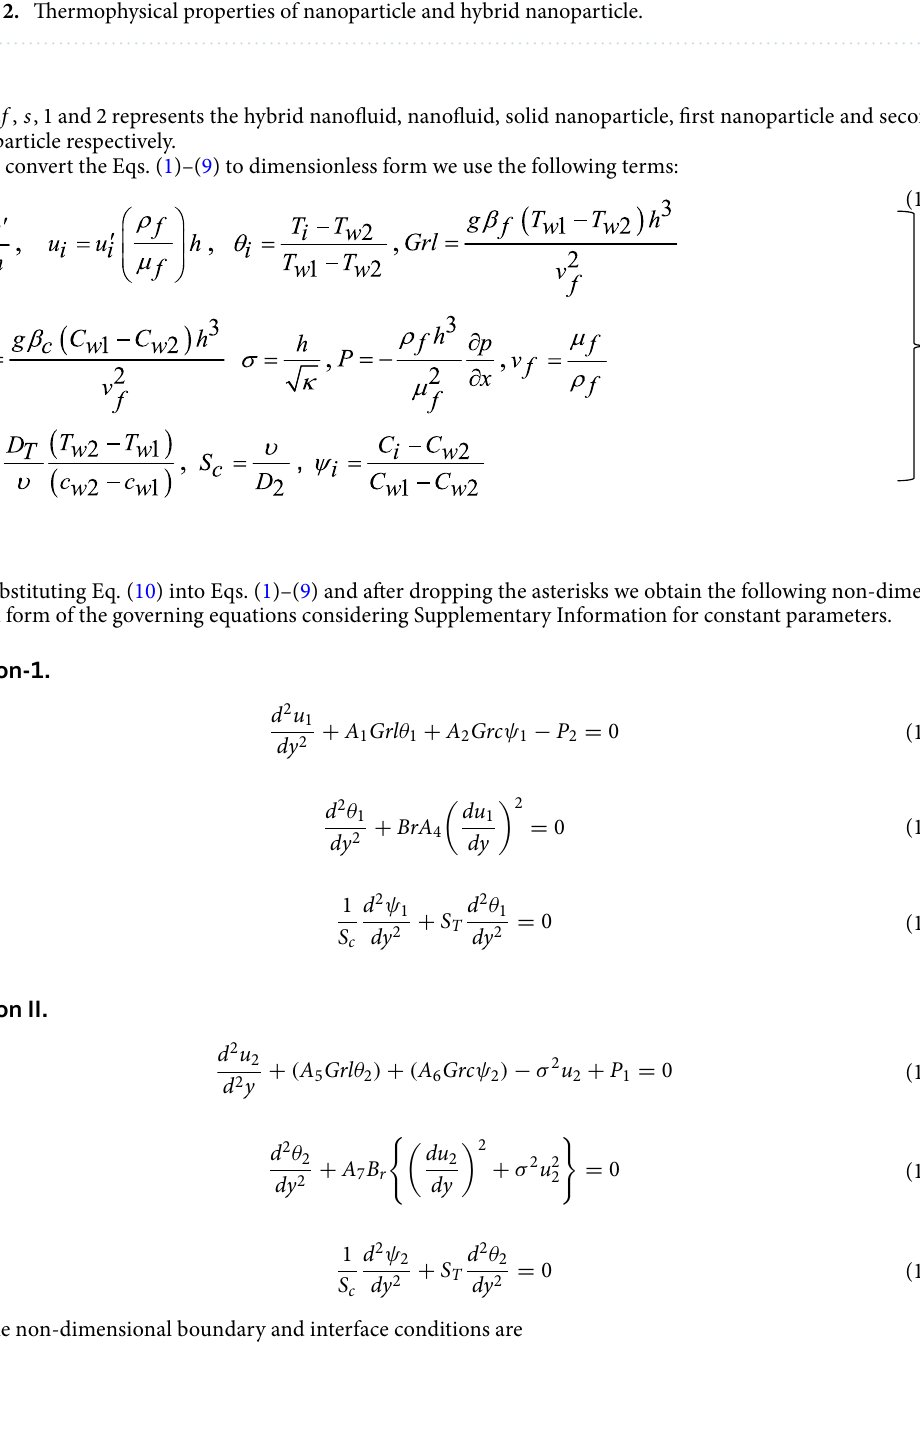
Table 2. Thermophysical properties of nanoparticle and hybrid